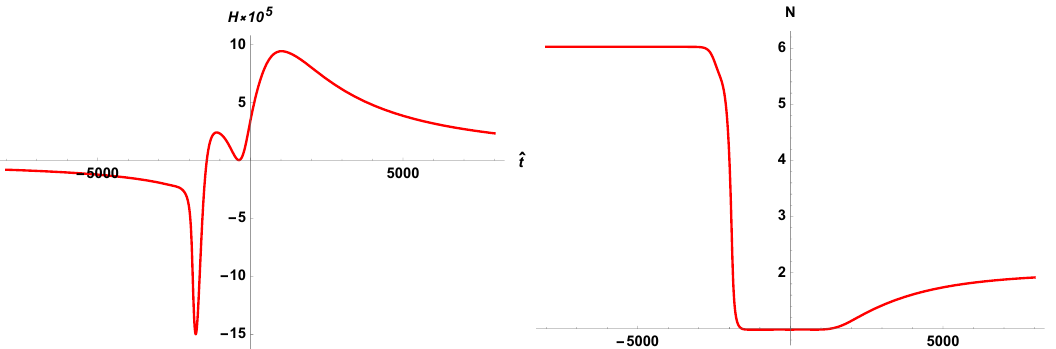
Figure 12 . Hubble parameter (left panel) and lapse function (right panel) for the model of appendix F: contraction, bounce and subsequent GR